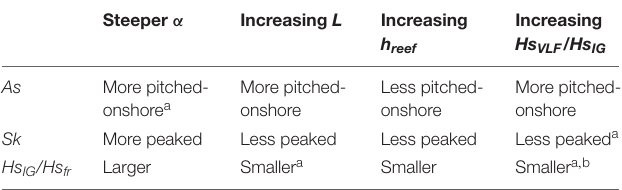
TABLE 2 | Summary of relationships found between reef characteristics and resulting infragravity (IG) waves at the inner reef flat. Steeper α Increasing L Increasing h reef As More pitched- More pitched- Less pitched- More pitched- onshore a onshore onshore onshore Sk More peaked Less peaked Less peaked Less peaked